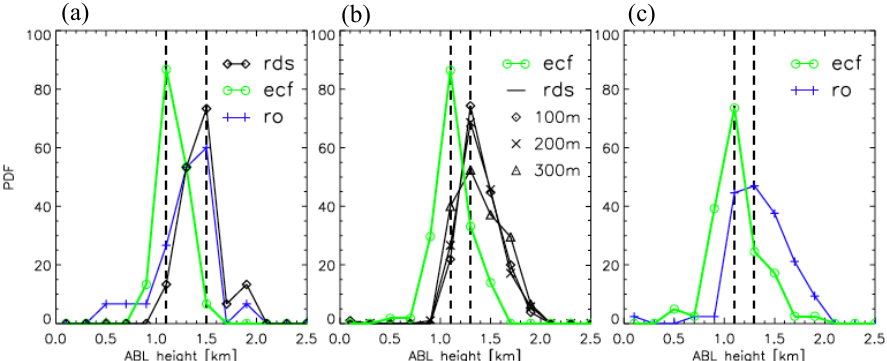
Fig. 4. The PDF of the ABL heights (a) for radiosondes (25 profiles, with 100-m smoothing) and the near-coincident COSMIC RO and ECMWF analysis; (b) for radiosonde (190 profiles) with three vertical smoothing intervals (100, 200 and 300m) and the near-coincident ECMWF analysis over the region (15–25 ◦ S, 70–86 ◦ W) from 25 October to 1 December 2008; (c) for COSMIC RO soundings (70 profiles) and the near-coincident ECMWF analysis over the region (20–25 ◦ S, 70–86 ◦ W) from 25 October to 1 December 2008. For better illustration, the normalized PDF is divided by 3 to scale the maximum PDF close to 100. The shape of the PDF is not changed due to the scaling.